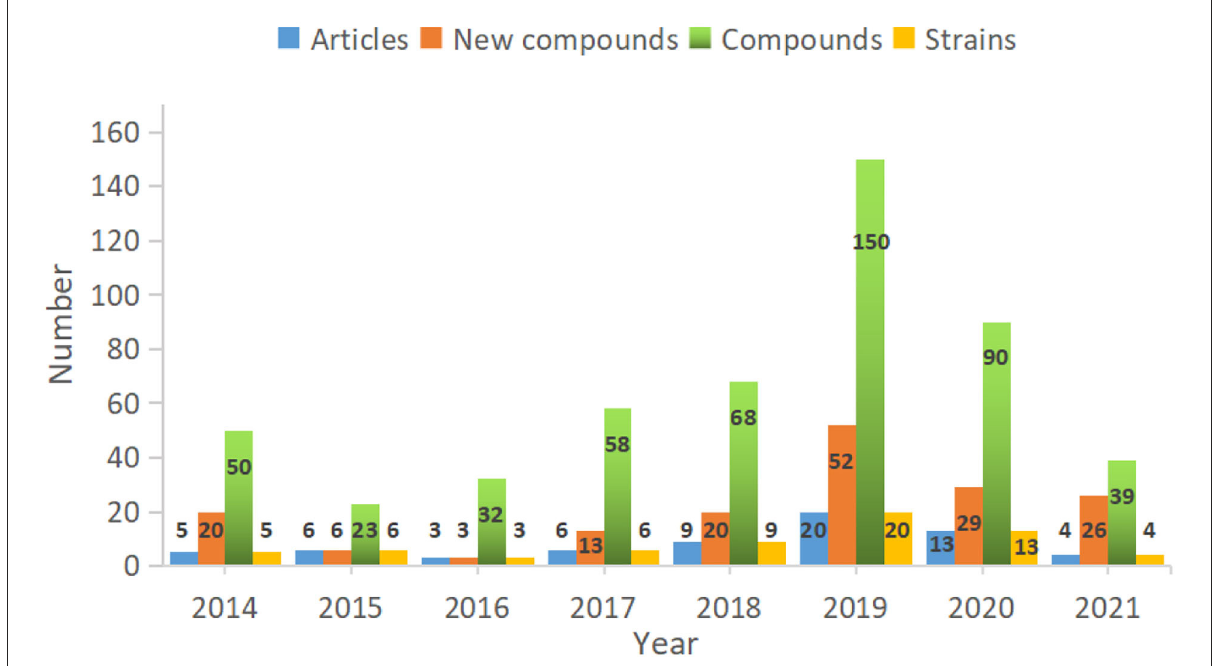
FIGURE16 The number of articles, compounds, and strains reported from Alternaria fungi in recent